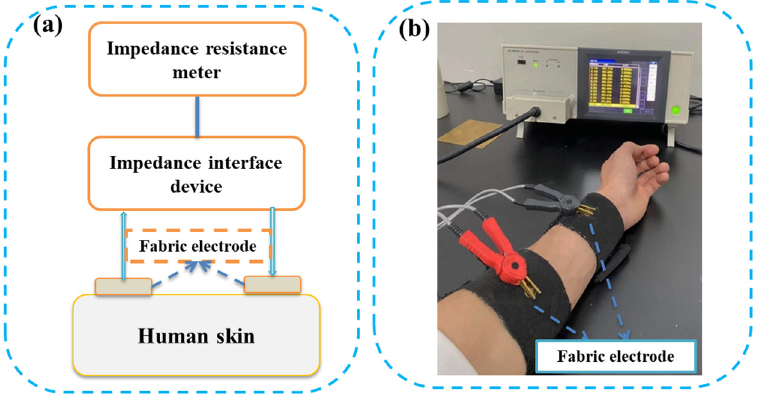
Figure 3 . The contact impedance test between the fabric electrode and the skin. ( a ) Schematic dia ‐ gram. ( b ) Test diagram. ( b ) Test